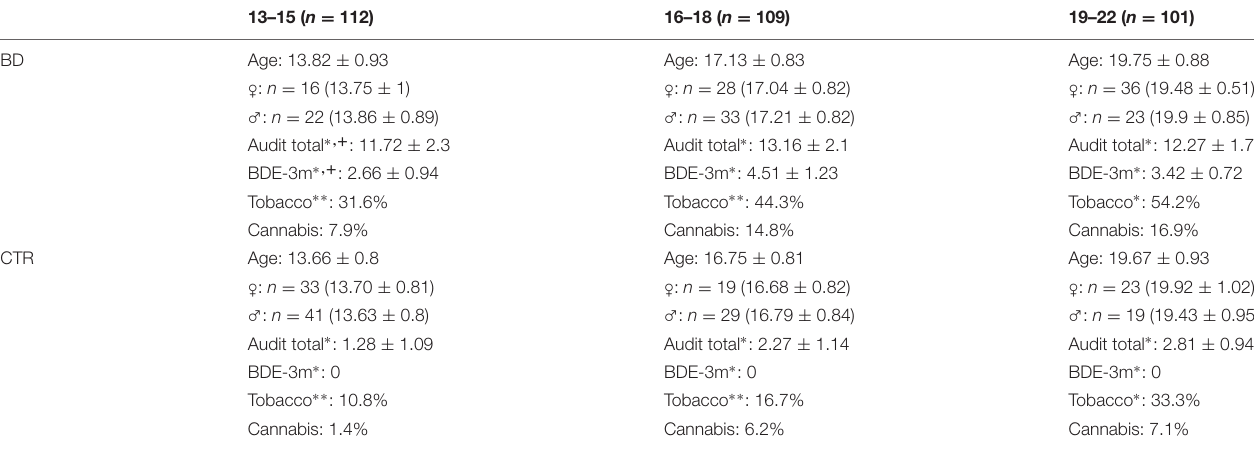
TABLE 1 | Configuration of the experimental groups and consumption